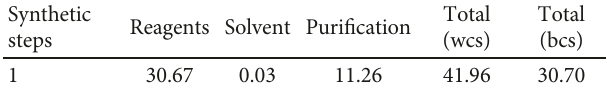
Table 5: Calculated synthesis cost for 1g of ( n -BuO) bulk quotation of 1kg of 4-n-butoxyphthalonitrile. Synthetic